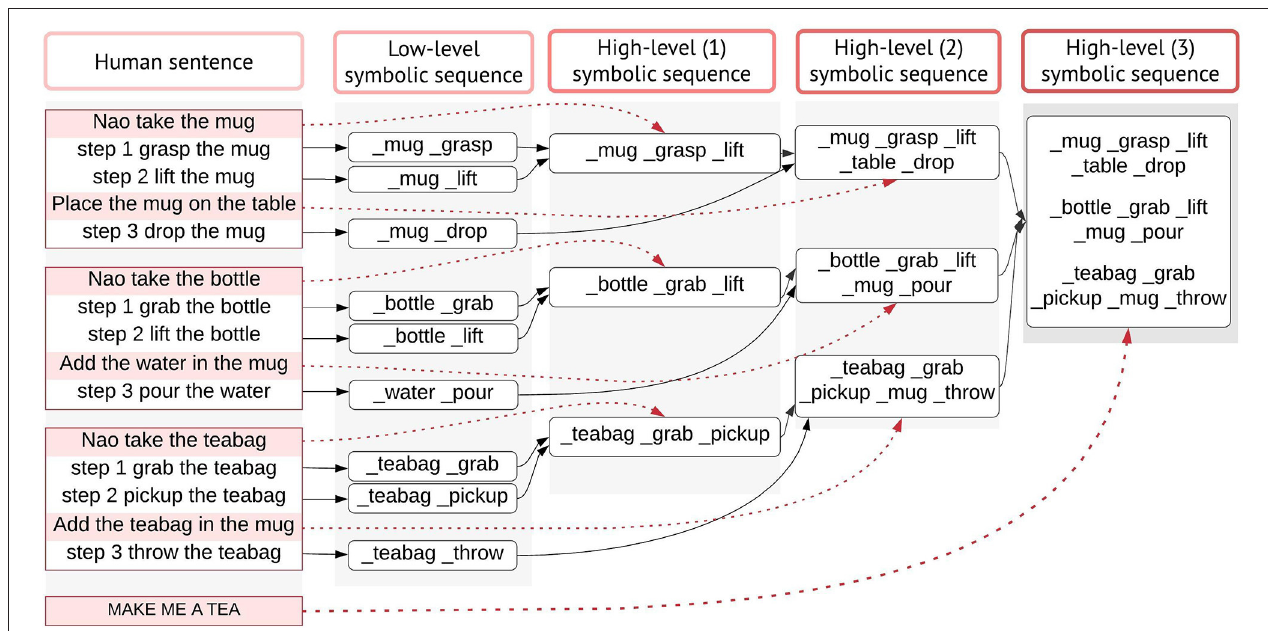
FIGURE 6 | Action learning. Primitive action semantics (i.e., concrete actions) are mapped directly to their internal motor representation and the < _action action > pairs are stored permanently in the long-term memory (LTM). For each instruction of type “step 1 do something,” the model produces a low-level symbolic sequence, by extracting the representations that have a < _word word > mapping in the LTM. For higher-order actions that do not have a direct symbolic representation of the action (e.g., take), the model retrieves and links the primitive action meanings that are instructed sequentially by the human. First high-level sequences are built by transferring the meaning of 2-step primitive actions. Second high-level sequences link the meanings from the predecessor level with the subsequent primitive action. Third high-level sequences are achieved by recalling the second high-level sequences. High-level symbolic sequences correspond to the representation of abstract notions (take, use, make) in lower-order non-linguistic primitives. The dotted lines indicate how high-level utterances are internally represented indirectly by associating lower-order representations. Notice how same abstract concepts (e.g., take) have different symbolic internal representations, depending on the